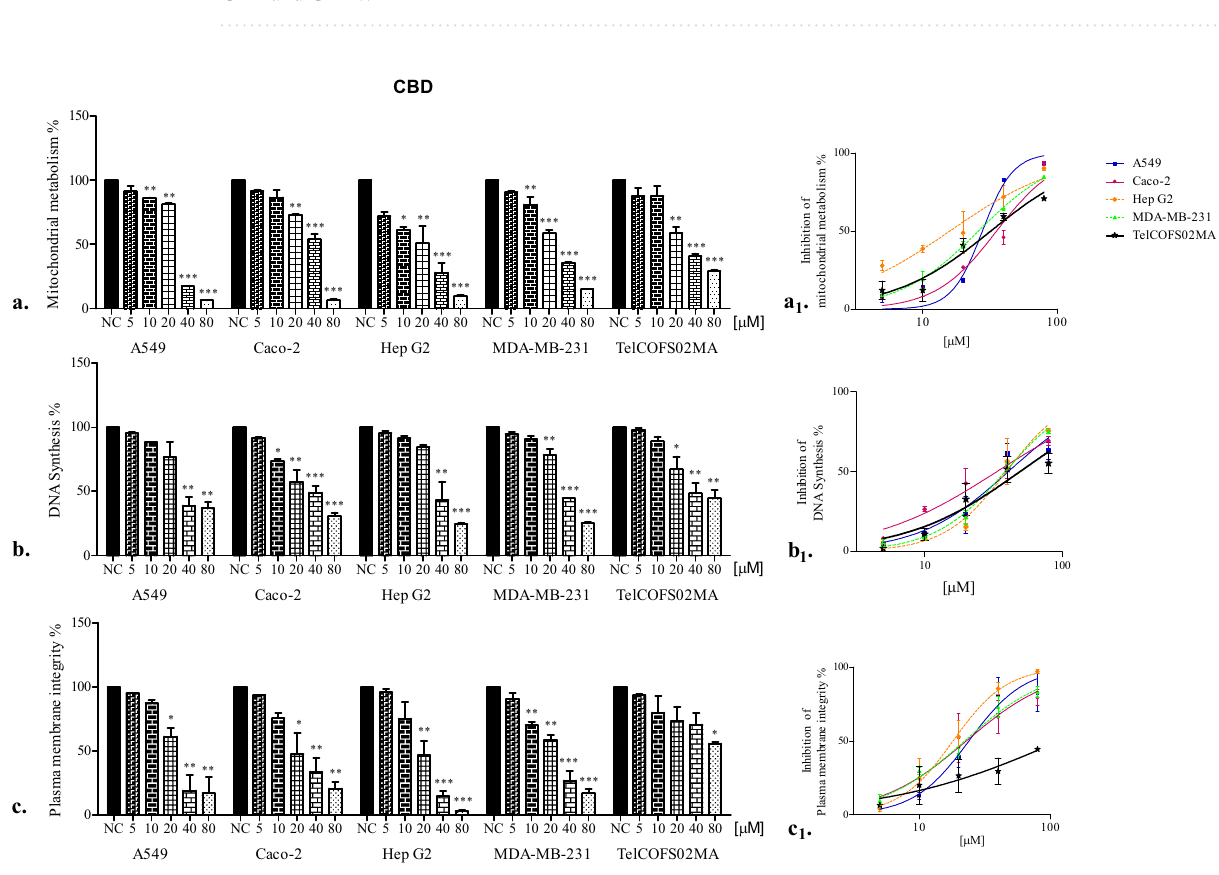
Figure 2. Percentages of cellular mitochondrial metabolism, DNA synthesis and plasma membrane integrity after 72 h of CBD exposure. Percentages of cellular mitochondrial metabolism ( a ), DNA synthesis ( b ) and plasma membrane integrity ( c ) after 72 h of exposure of the A549, Caco-2, HepG2, MDA-MB-231, and TelCOFS02MA cell lines to different concentrations of CBD. The results are expressed as the means ± standard deviation on the basis of five independent experiments. Significant differences compared to negative controls are highlighted by asterisks (ANOVA, Dunnett’s test—*p < 0.05; **p < 0.001; ***p < 0.0001) . Percentages of inhibition of cellular mitochondrial metabolism ( a 1 ), DNA synthesis ( b 1 ), and inhibition of plasma membrane integrity ( c 1 ) after 72 h of exposure are reported in concentration [µM]-effect curves. NC: negative